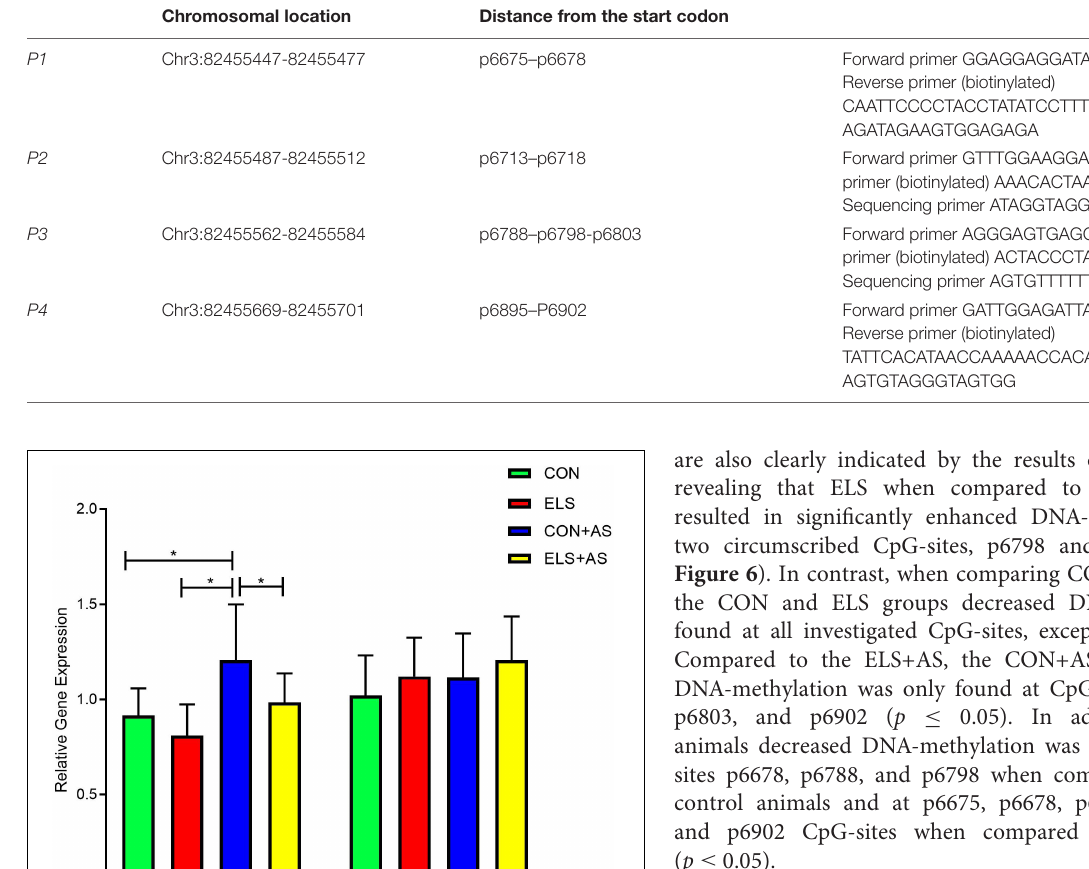
TABLE 1 | Designed Y2 receptor gene primers used for DNA-methylation. Chromosomal location